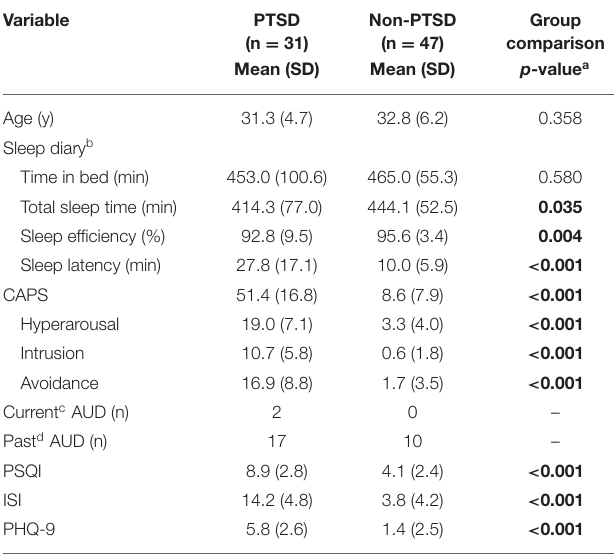
TABLE 1 | Clinical characteristics and sleep-diary variables for the 78 combat-exposed Veteran men in our study. Variable